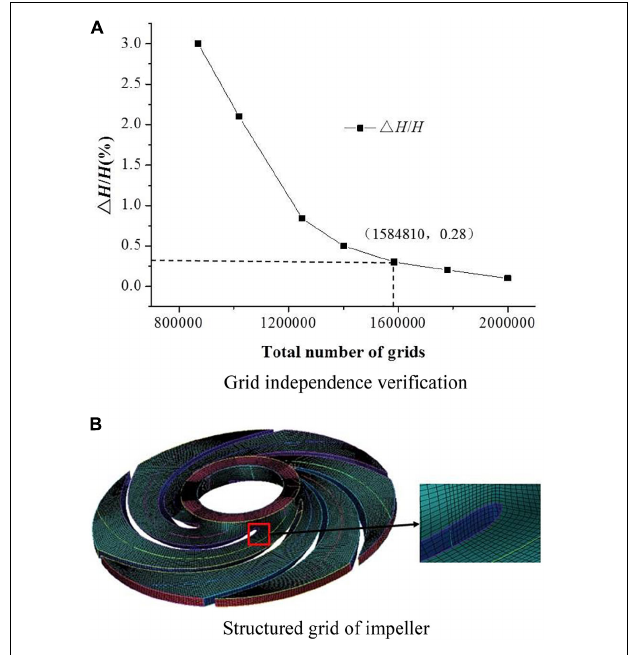
FIGURE 2 | Meshing. (A) Grid independence verification, (B) Structured grid of impeller.